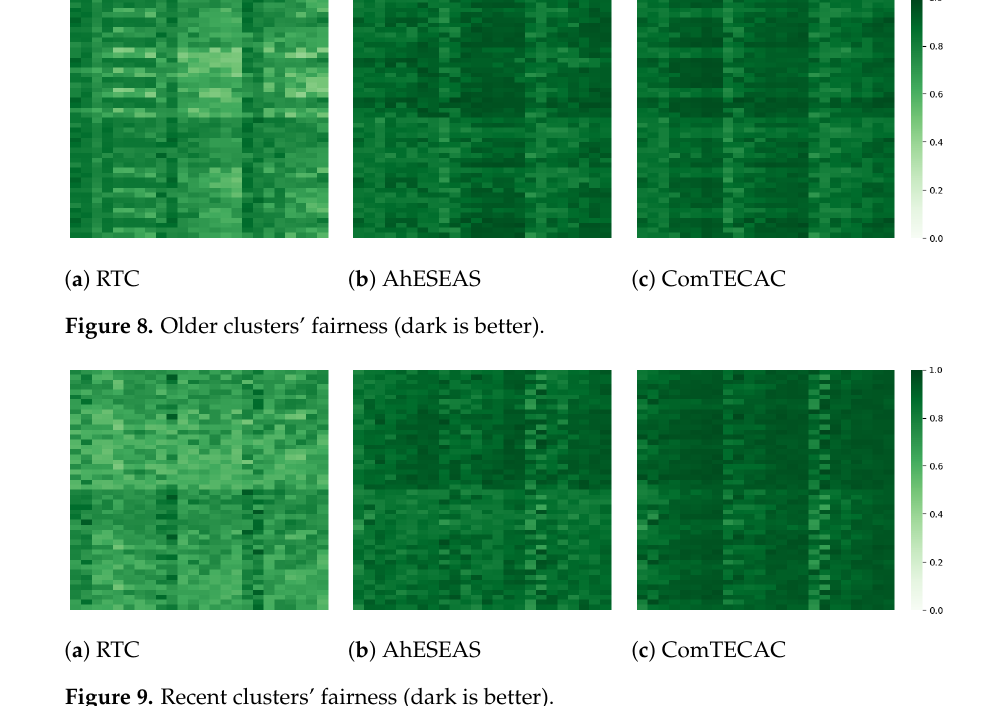
Figure 9. Recent clusters’ fairness (dark is